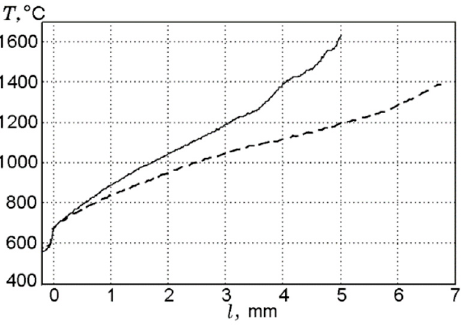
Figure 18. Temperature profiles in the diffusion flames of UHMWPE (solid curve) and UHMWPE + 10% TPP (dashed curve) in air. 10% TPP (dashed curve) in